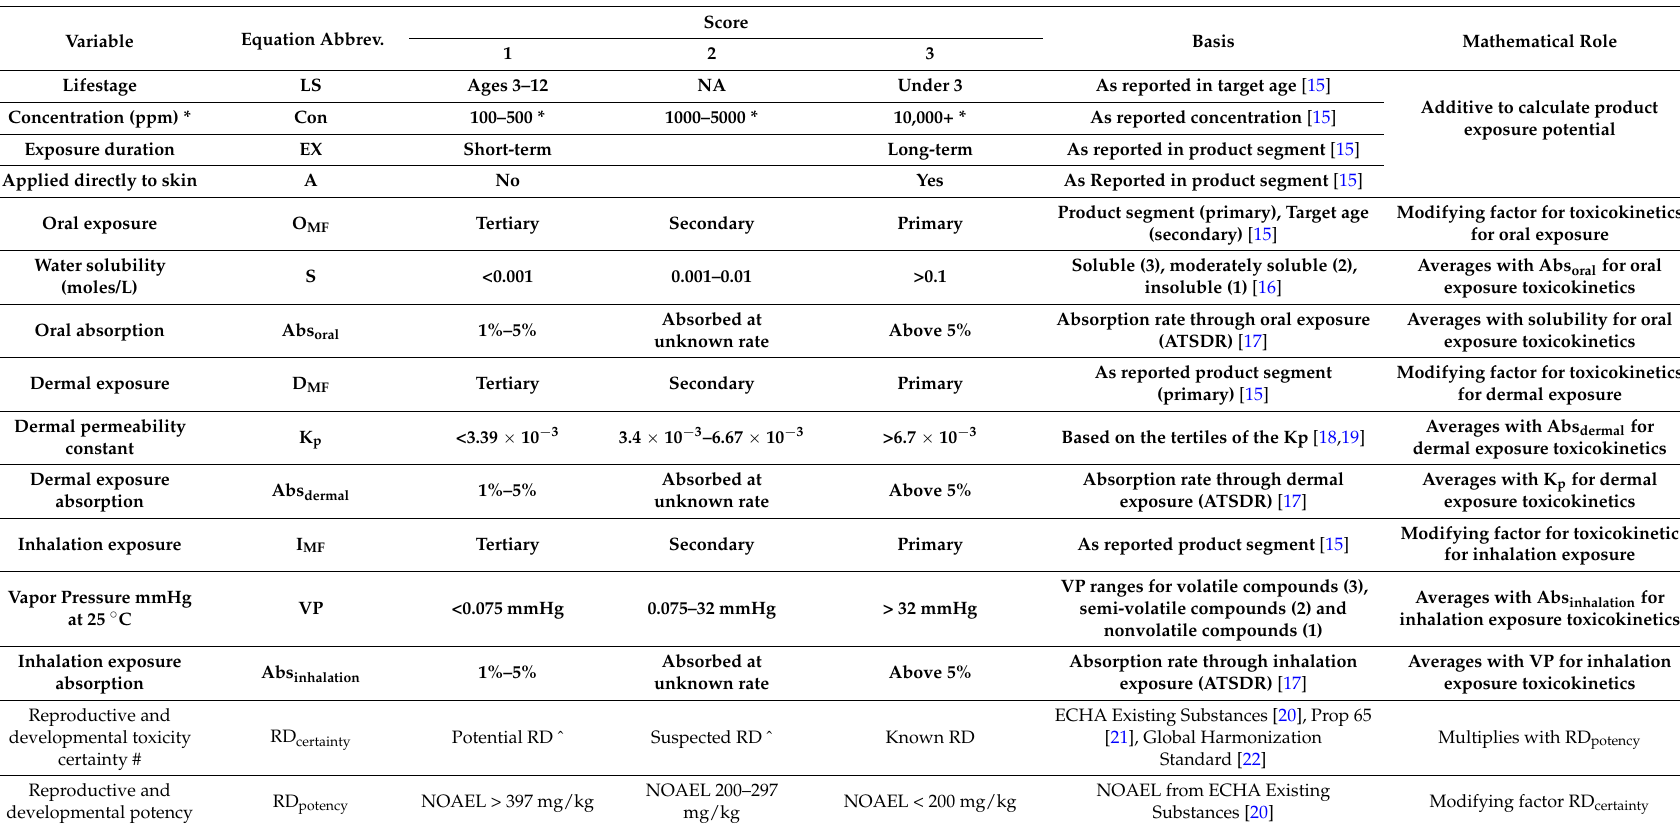
Table 1. Equation variables and basis for calculating the scores. Variables were assigned a score on a 0–3 scale based on reported data in CSPA (lifestage, concentration, exposure duration, exposure routes) or chemical factors (chemical properties, toxicokinetics, toxicity and potency). Variables for the exposure score are in bold and variables for the toxicity score are not in